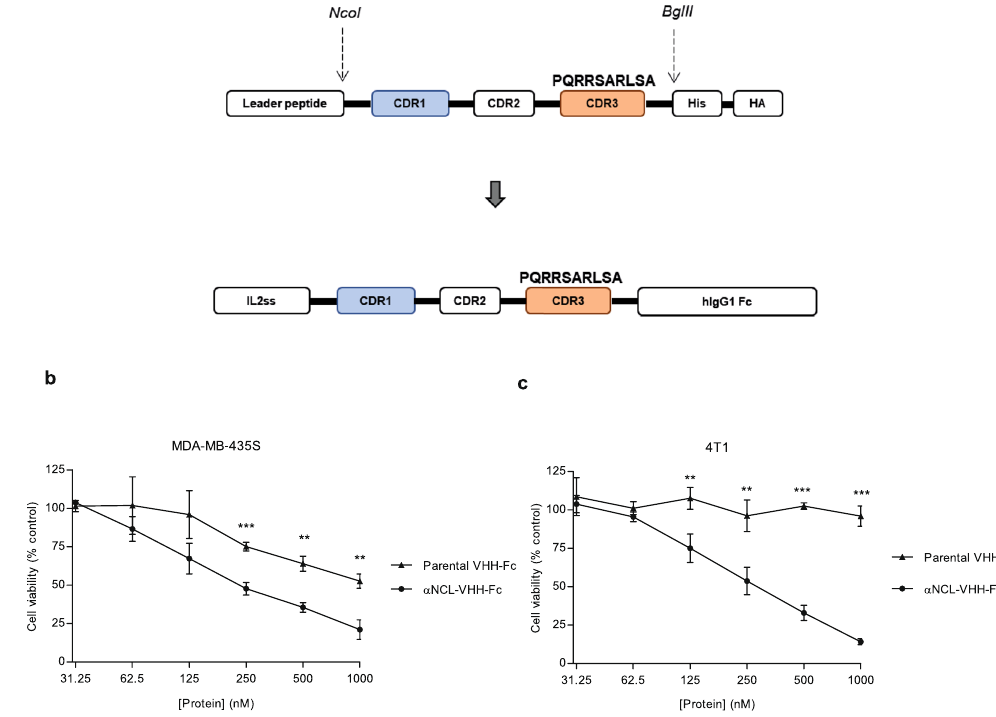
Figure 4. Cytotoxicity of an anti-nucleolin VHH-Fc antibody against nucleolin-overexpressing cancer cells. ( a ) An anti-nucleolin VHH-Fc antibody ( α NCL-VHH-Fc) was generated by fusing α NCL-CDR3 to a human IgG1 Fc region and then incubated with ( b ) MDA-MB-435S or ( c ) 4T1 nucleolin-overexpressing cancer cells, at concentrations up to 1000 nM, for 72 h at 37 °C. The parental VHH-Fc antibody, without the targeting component to nucleolin, was included as control. In the end of the incubation, cytotoxicity was assessed by the MTT assay. Data represent the mean ± SD of three independent experiments, performed in duplicate. Differences in cytotoxicity between the VHH-Fc antibodies were evaluated by Student’s t-test ( ** p < 0.01, *** p <